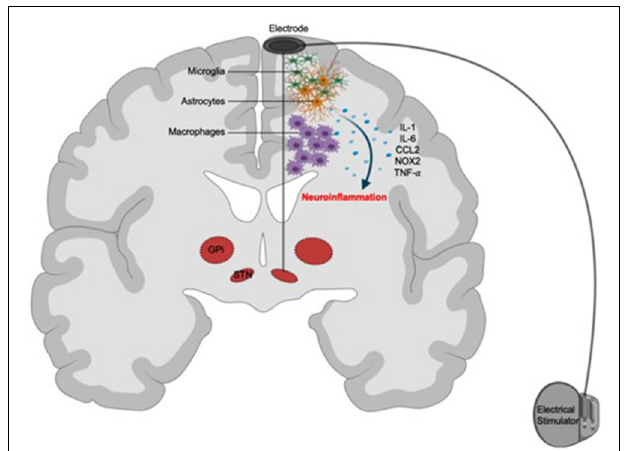
FIGURE 2 | Putative immunological mechanisms of suicide associated with DBS. Surgical implantation of neuroelectrodes might cause immunoreactivity against these devices. Focal activation of recruited peripheral macrophages and brain resident microglia and astrocytes (glial scarring) in response to the electrodes triggers the release of inflammatory mediators, such as IL-1, IL-6, CCL2, NOX2, and TNF- α , resulting in neuroinflammation and subsequent aggravation of psychosocial risk factors for